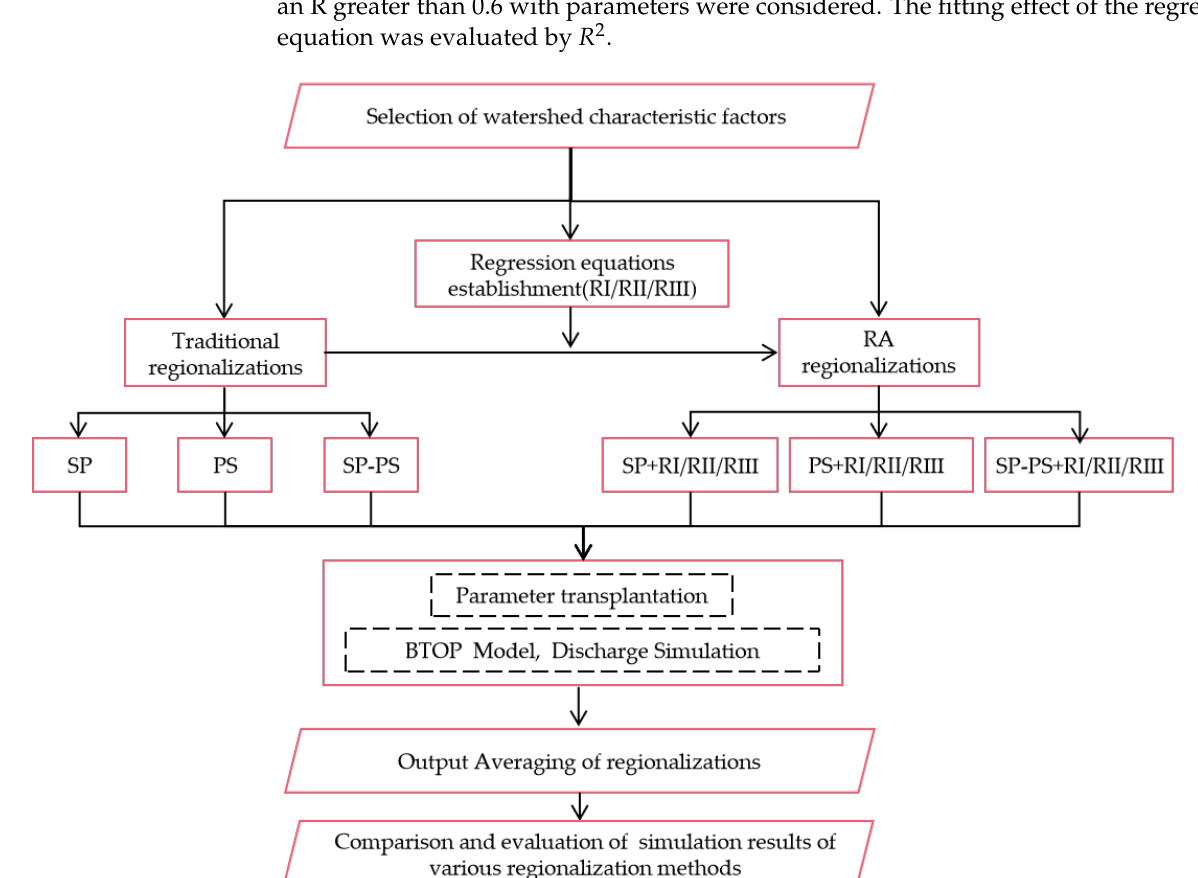
Figure 2. The framework of the study. SP, PS, and SP-PS are abbreviations for spatial proximity approach, physical sim- ilarity approach, and an integration similarity approach (SP-PS); the R I, RII, and R Ⅲ represent regression equations with different numbers of independent variables.